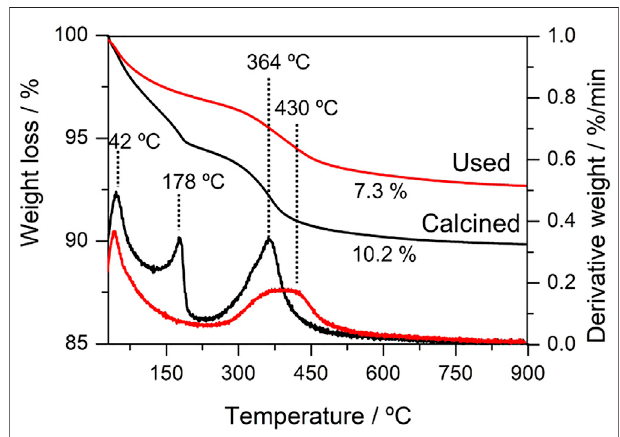
FIGURE 3 | TGA pro fi les of calcined and spent catalysts (MgAl 2 O 4 ).